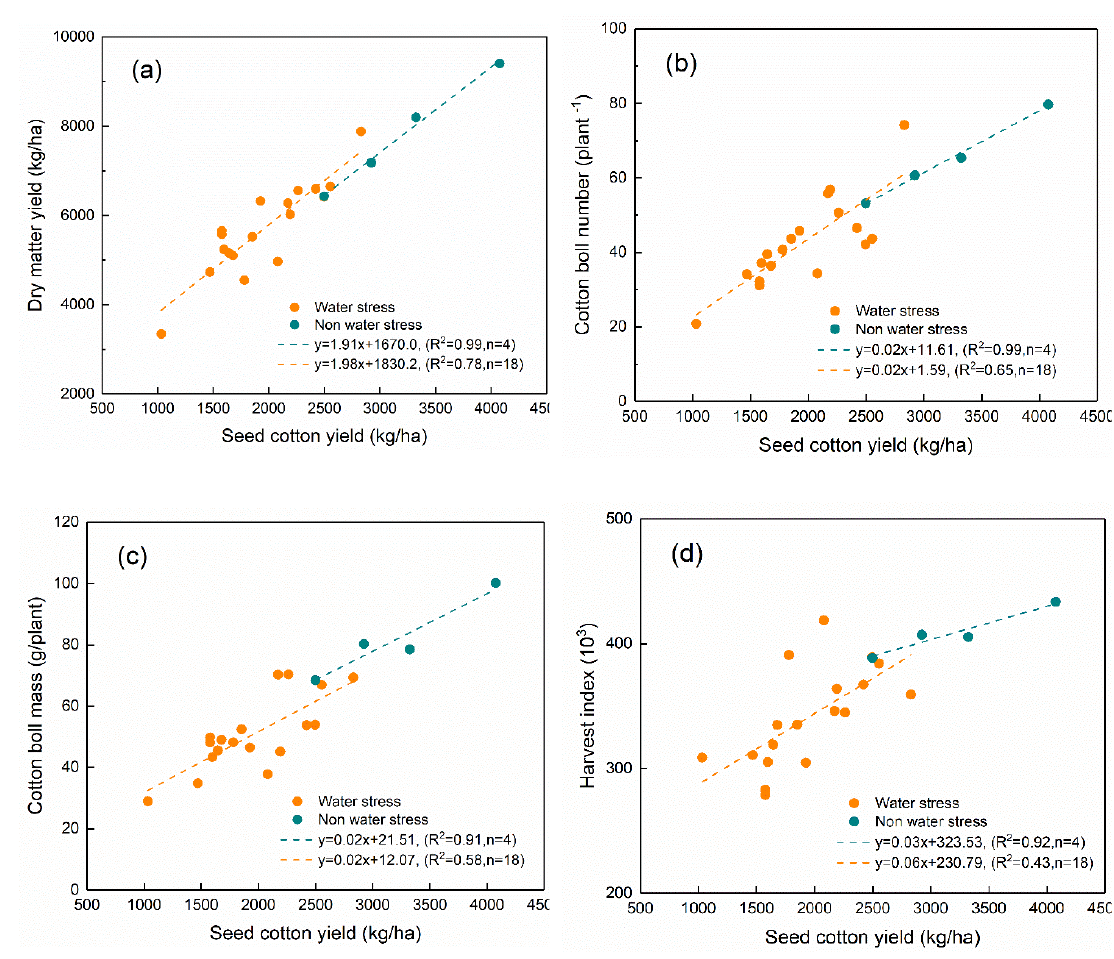
Figure 3. Linear regressions between seed cotton yield and dry matter yield ( a ), boll number ( b ), boll hull mass ( c ), and harvest index ( d ) underwater stress and non-water stress conditions. All the presented regression formulas are highly significant, p < 0.01. The non-water stress conditions employed data from the four lysimeters of the CK treatment; the water stress conditions employed data from eighteen lysimeters, including 15 from our five flood and drought treatments (three replicates for each treatment) and three from another three lysimeters that experienced an eight-day flood followed by long-term low soil moisture. The three supplementary lysimeters were part of an original attempt to establish an eight-day flood followed by a 15-day drought, but the soil moisture did not fall below (but very close to) 50% FC until harvest; thus, their water regimes were also considered as flood followed by drought conditions and included to provide more data for regression analysis.